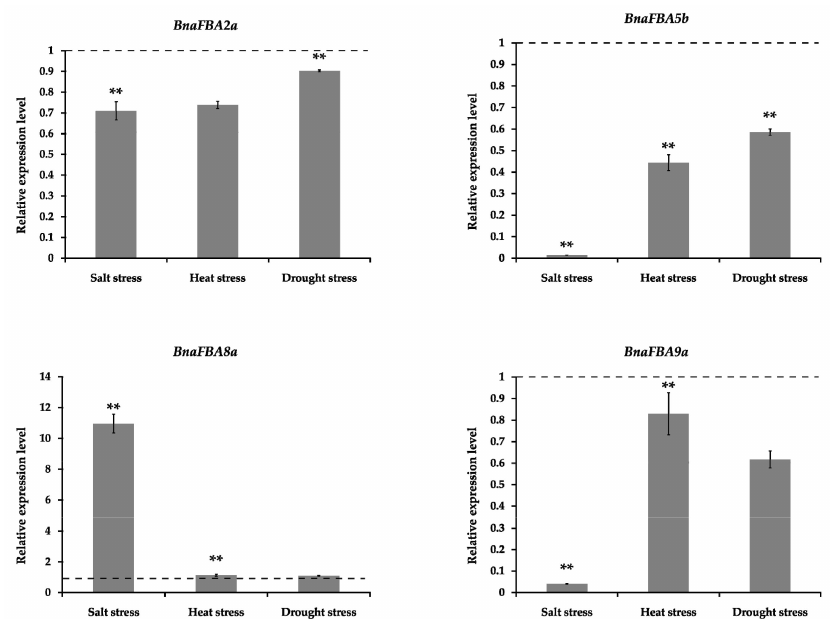
Figure 7. The real-time PCR analysis of the selected four representative BnaFBA genes responded to salt, heat, and drought stresses. The dotted lines represent the equivalent levels of expression. Statistically significant di ff erences (Student’s t -test) are indicated as followed: ** p <